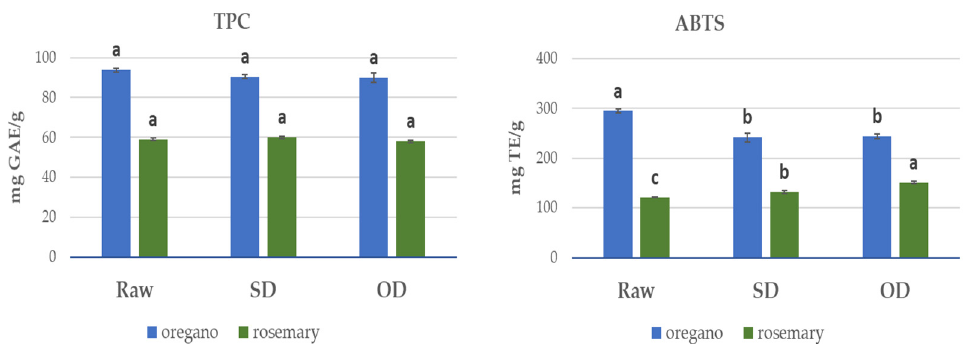
Figure 1. Main effects plot for the total phenolic content (TPC, mg GAE/g) and ABTS radical scavenging activity (mg TE/g) of raw and solid residues after steam distillation of oregano and rosemary; values followed by different letters in the bars in the same attribute are significantly different ( p ≤ 0.05) according to Tukey’s test.